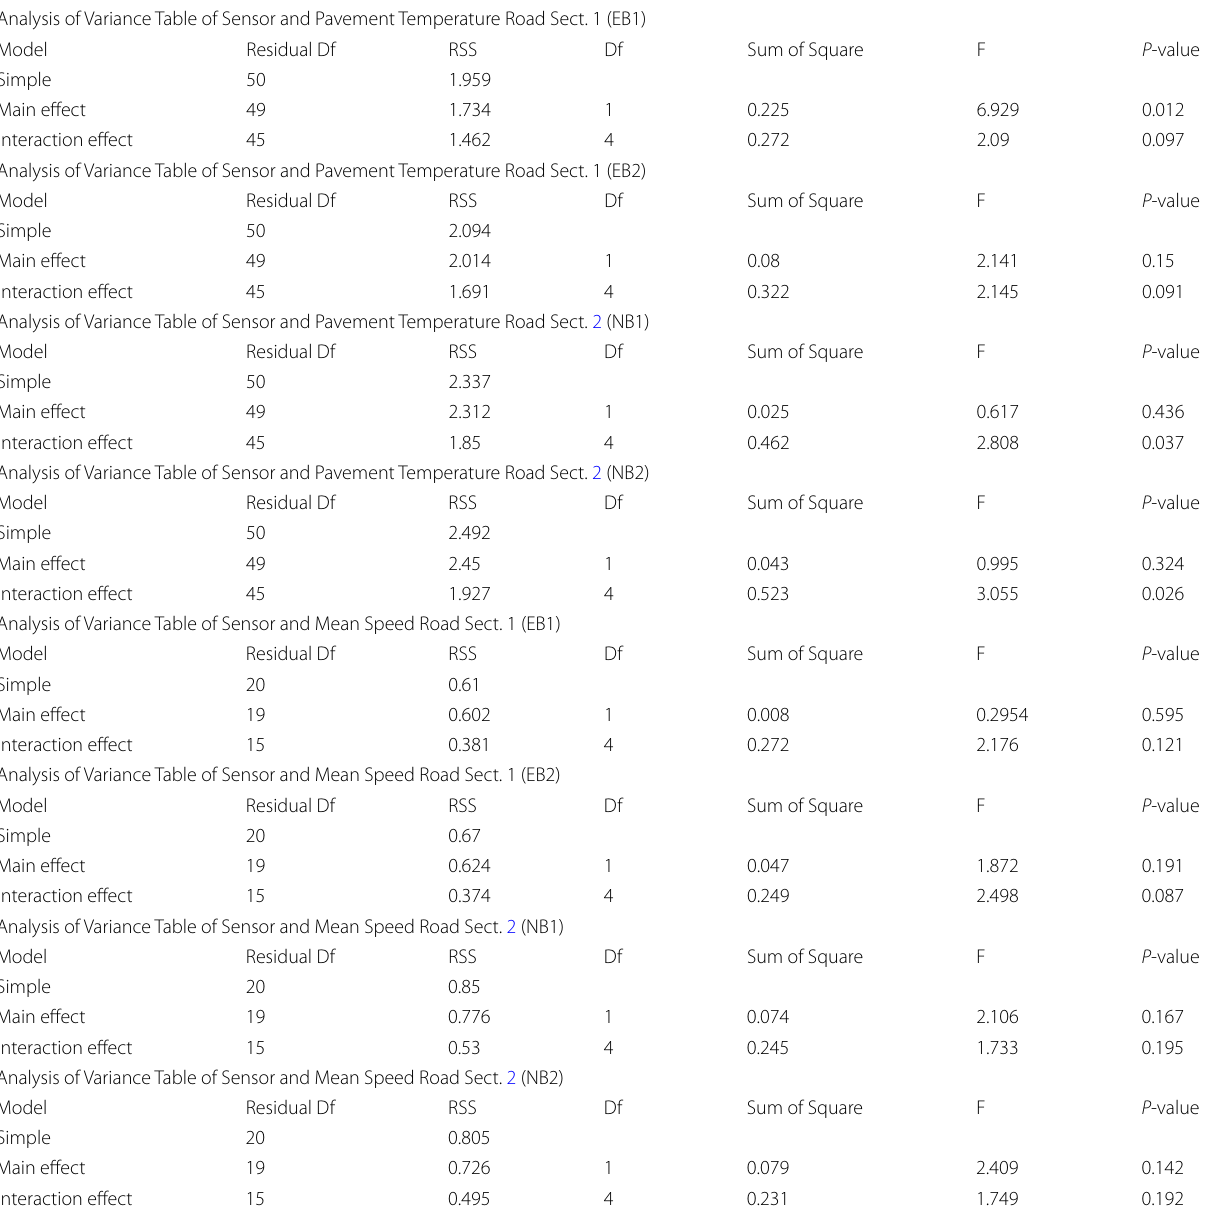
Df represents degrees of freedom and RSS represents residual sum of squares